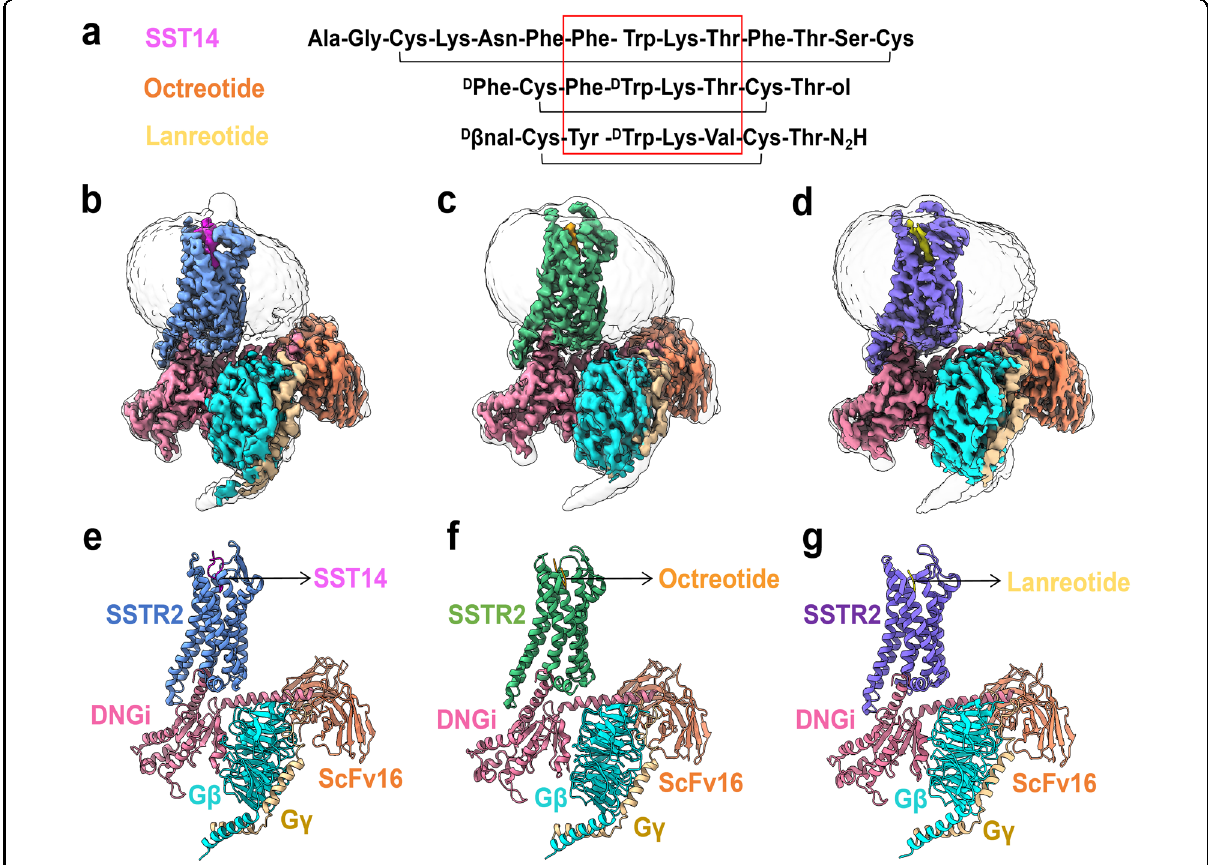
Fig. 1 The cryo-EM structure of SSTR2 – DNGi complex. a Peptide sequence alignment of SST14, octreotide and lanreotide. b – d Cryo-EM density maps of SST14 ( b ) or octreotide ( c ) or lanreotide ( d ) bound SSTR2 – DNGi complex. e – g Ribbon diagram representation of the cryo-EM structures of SST14 ( e ) or octreotide ( f ) or lanreotide ( g ) bound SSTR2 – DNGi complex, colored by subunit (TMDs in sea green, SST14 in magenta, octreotide in orange, lanreotide in yellow, G α i in hot pink, G β in cyan, G γ in gold, ScFv16 in